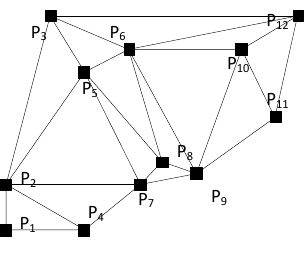
Figure 4. Delaunay